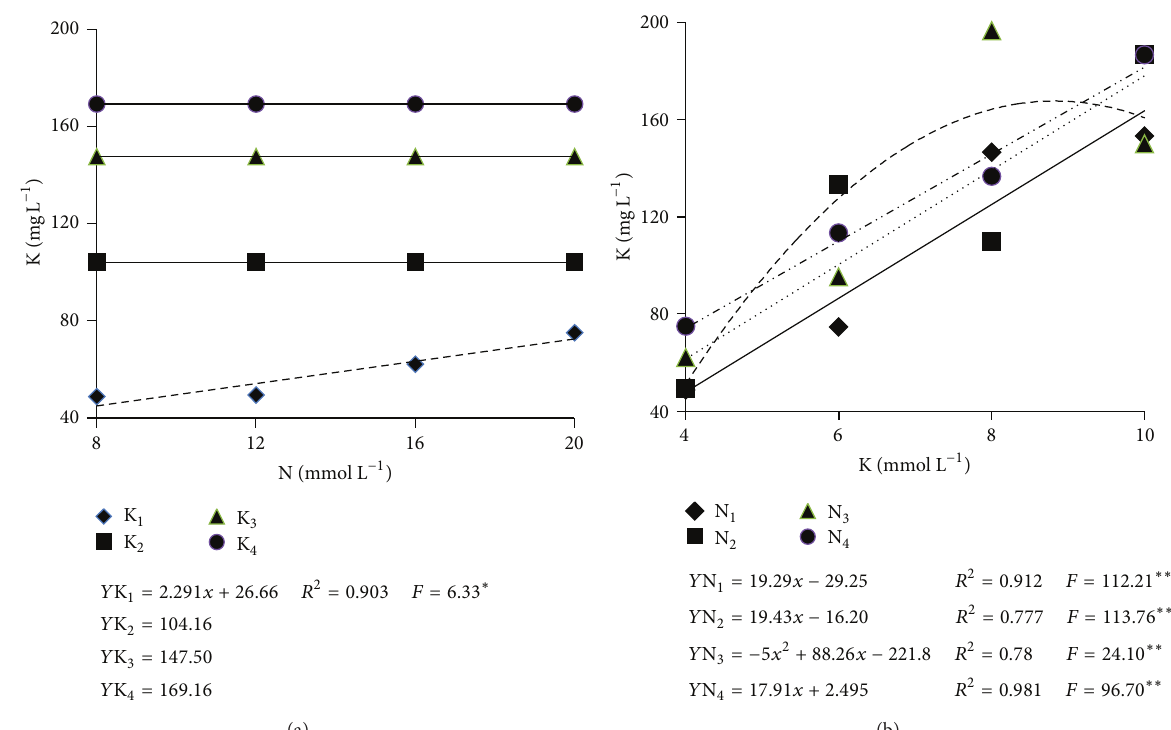
Figure 4: K levels (mgL −1 ) in the substratum solution extract (method 1:1.5 v/v) 60 days after transplantation as influenced by the concentrations of N (a) and of K (b) in the nutrients solution. ∗∗ , ∗ : Significant at the levels of 1 and 5%, respectively, according to the 𝐹 test.